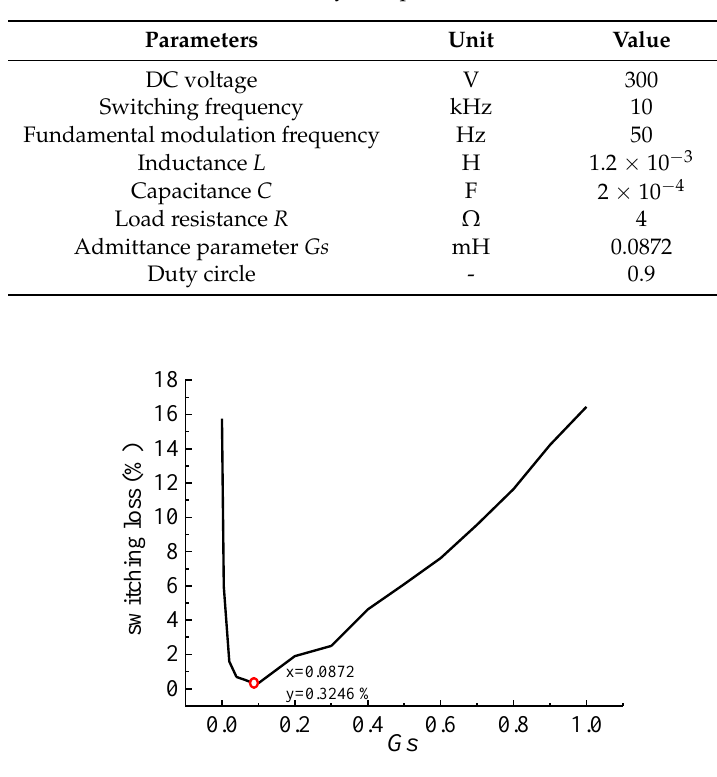
Table 1. System parameter.